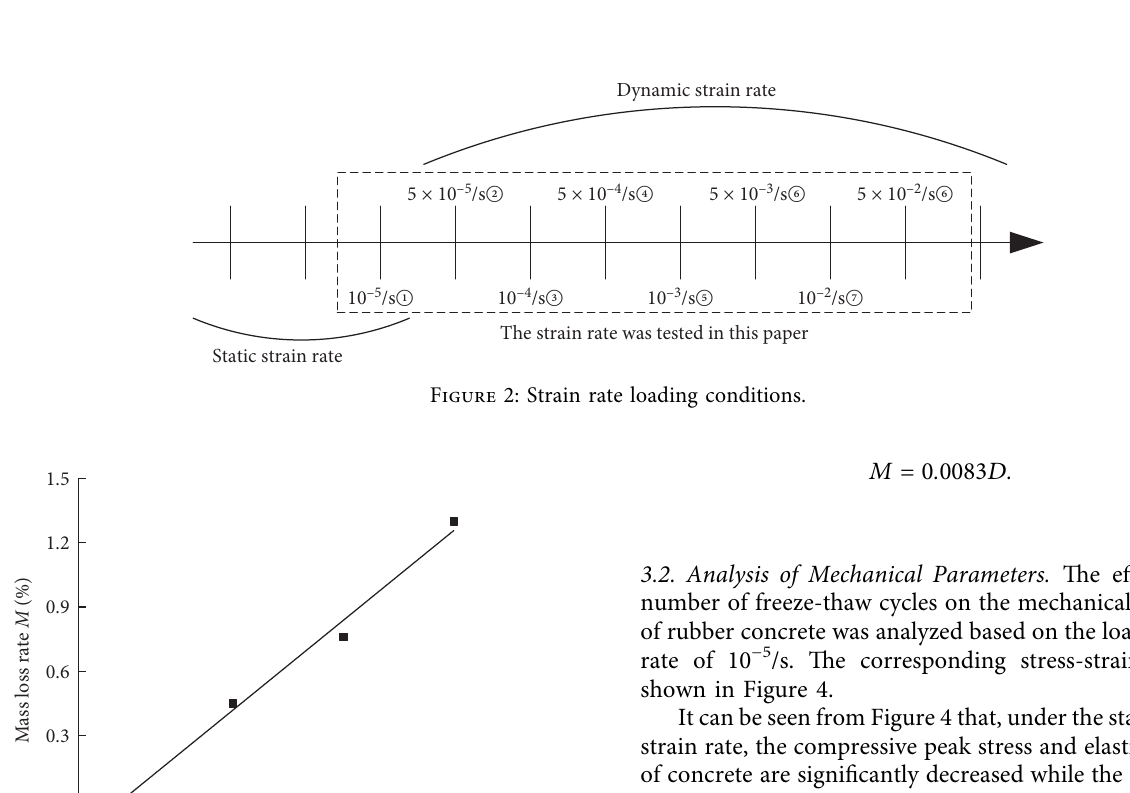
Figure 1: Equipment for freeze-thaw cycle test and loading. (a) Equipment for freeze-thaw cycle test. (b) Loading equipment.